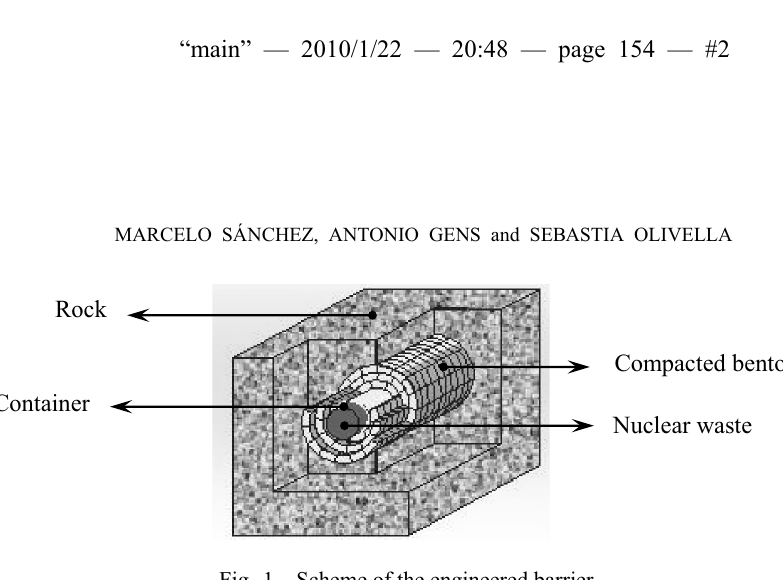
Fig. 1 – Scheme of the engineered